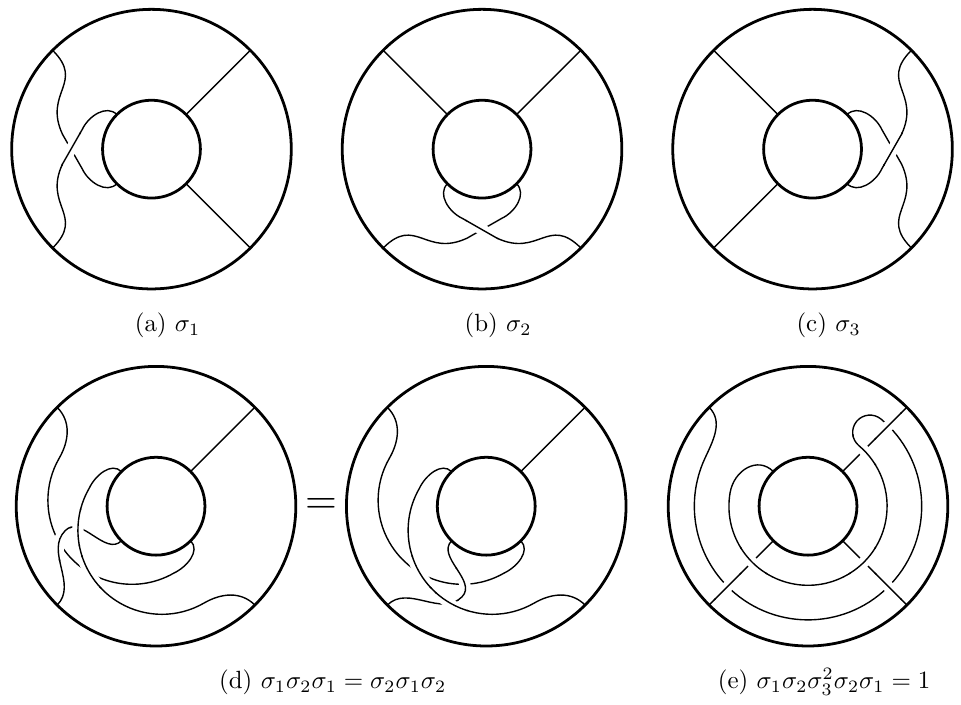
Figure 4. The spherical braid group generators and relations: B 4 ( S 2 ) is generated by (cid:27) 1 ; (cid:27) 2 ; (cid:27) 3 , with the relations (cid:27) 1 (cid:27) 3 = (cid:27) 3 (cid:27) 1 , (cid:27) 1 (cid:27) 2 (cid:27) 1 = (cid:27) 2 (cid:27) 1 (cid:27) 2 , (cid:27) 2 (cid:27) 3 (cid:27) 2 = (cid:27) 3 (cid:27) 2 (cid:27) 3 , and (cid:27) 1 (cid:27) 2 (cid:27) 2 outer in inner circles represent cross-sections through a two-sphere so, for example, the last braid is trivial because the strand can be unwrapped around the front and back of the internal S 2